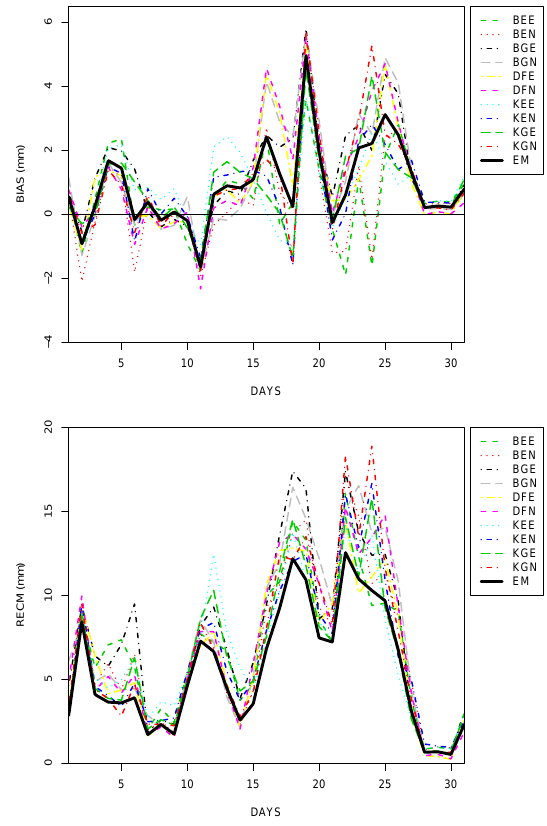
Fig. 3. Temporal evolution of bias (a) and RMSE (b) for each en- semble member and the ensemble mean of the total daily precipita- tion, spatially averaged over the region. Units are in mm/m 2 . The x-axis indicates the days of the period